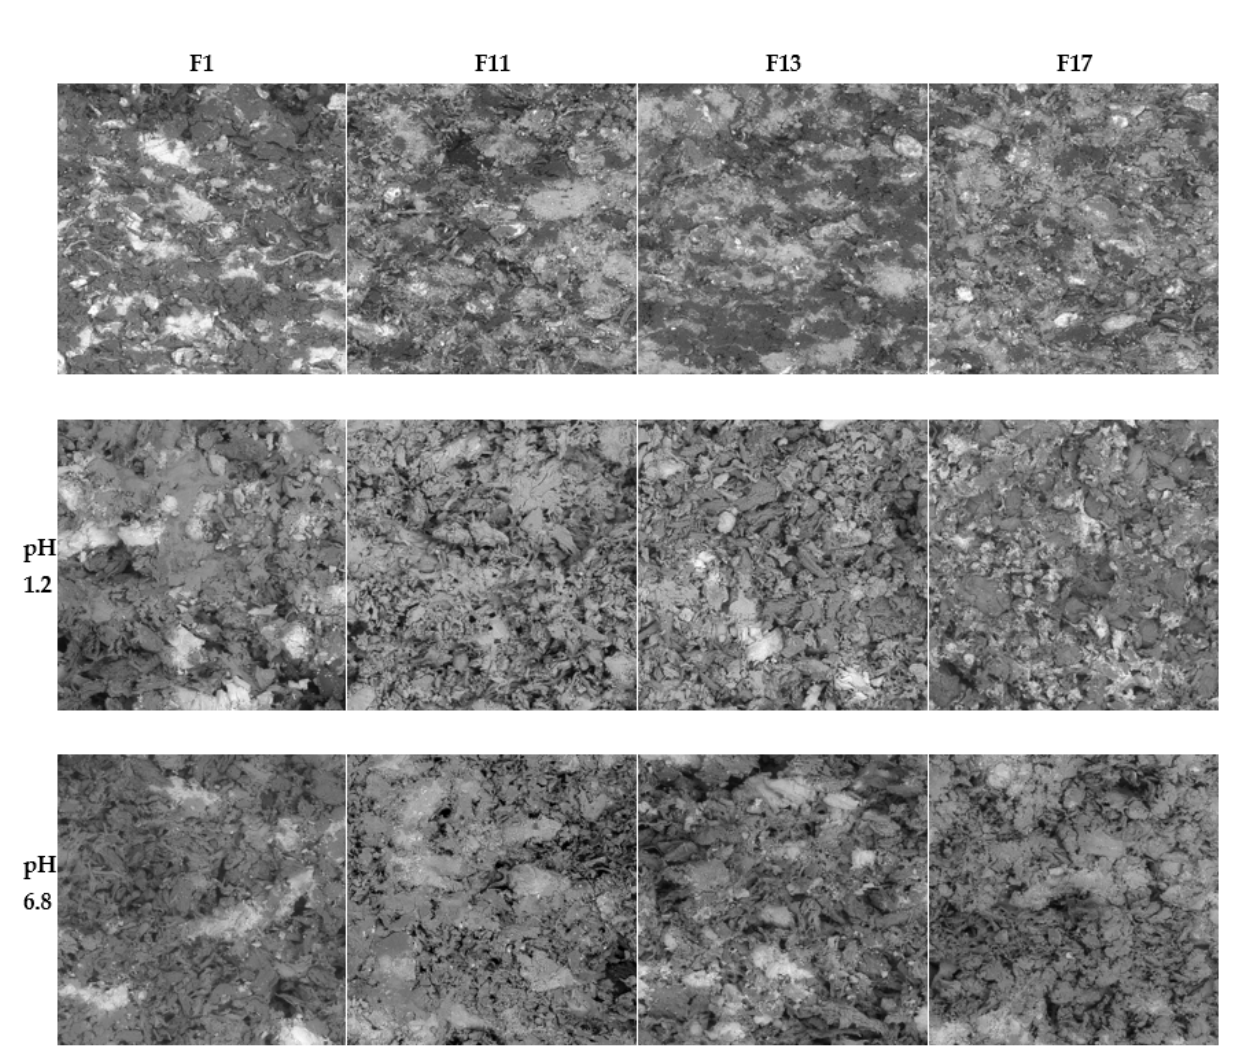
Figure 6. Cross-section cuts of the F1, F11, F13, and F17 matrix tablets before dissolution ( upper row ), after dissolution in pH = 1.2 ( middle row ), and after dissolution in pH = 6.8 ( bottom row ) as viewed using SEM. The dimensions of each micrograph are 1 mm × 1 mm.